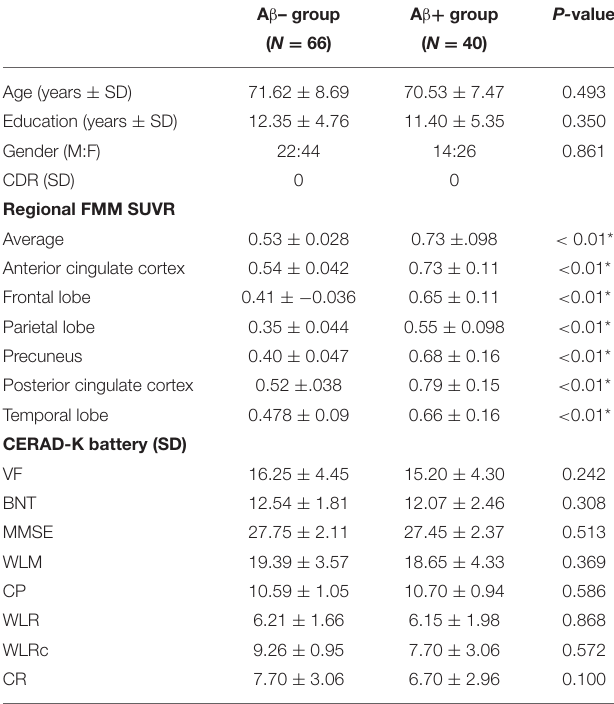
TABLE 1 | Demographic and clinical characteristics of the study participants.